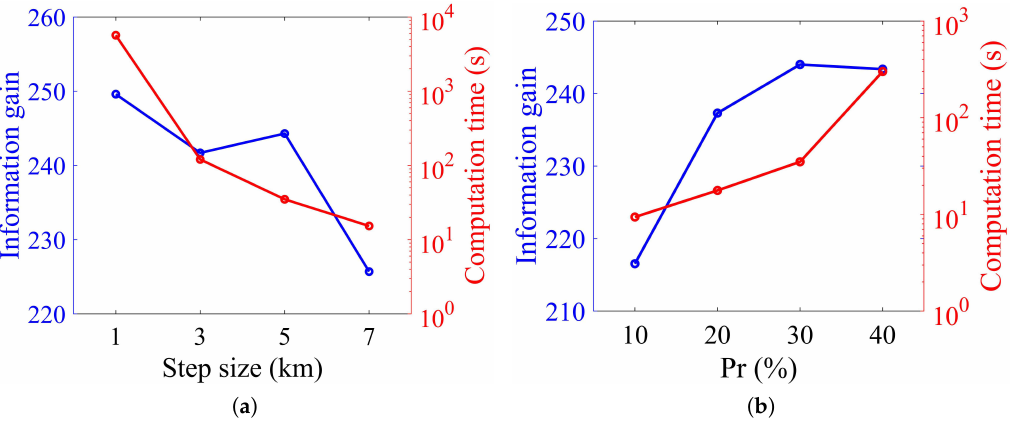
Figure 2. Comparison of parameter analysis for RAST*. ( a ) Step size, ( b ) maximum ratio